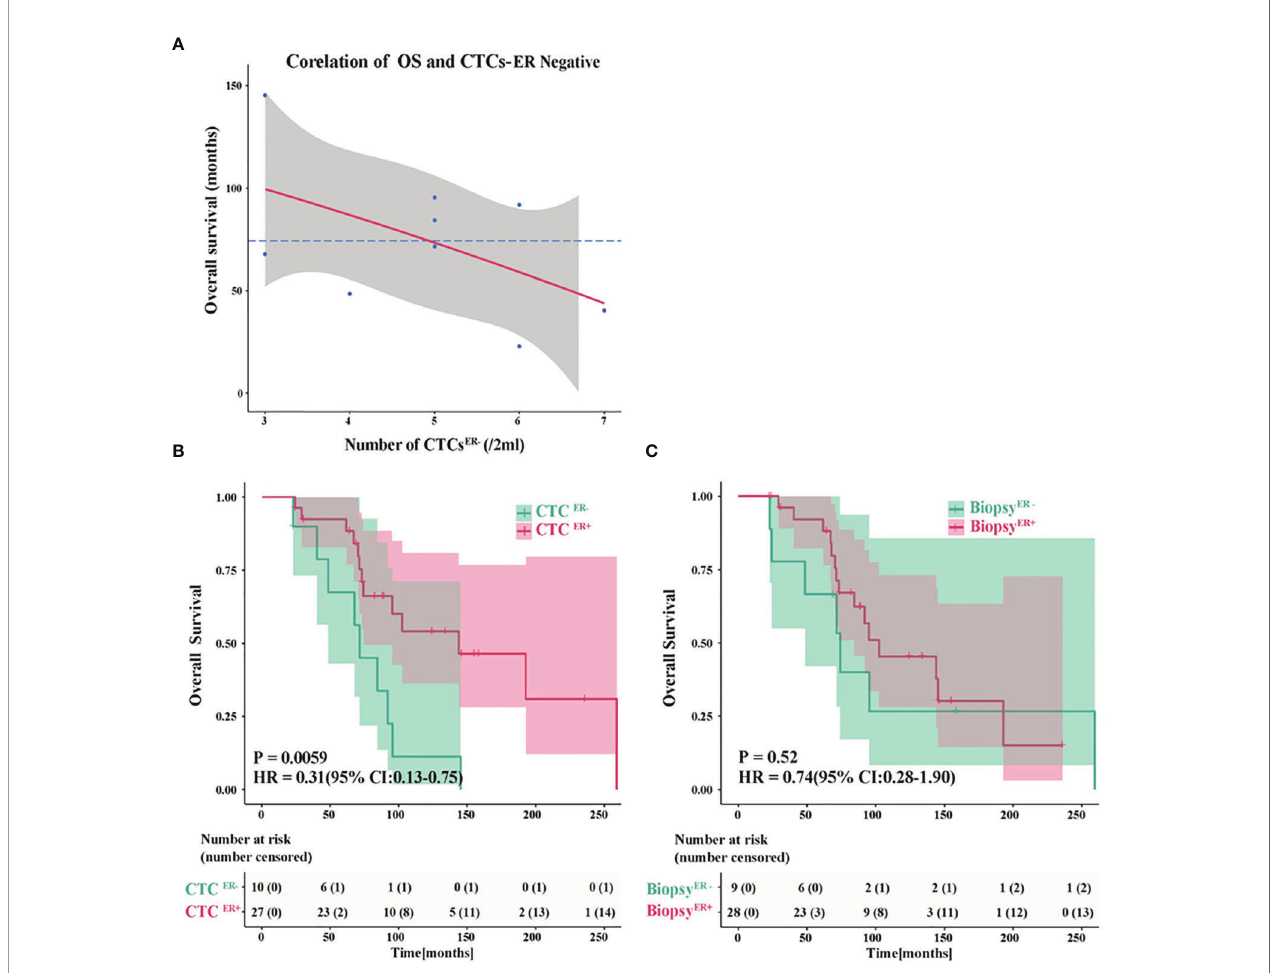
FIGURE 5 | Evaluation of the ER status in CTCs to predict OS. (A) An inverse correlation between the number of CTC ER- and OS in patients whose CTCs were negative for ER. (B) The probability of OS in patients with CTC ER+ was prominently different from that in CTC ER- group (P<0.01). (C) The OS showed no signi fi cant difference between ER-positive and ER-negative patients based on the ER status of primary tumor or metastatic IHC